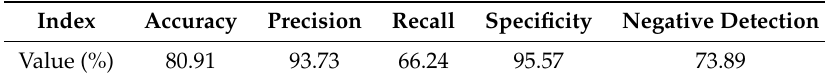
Table 21. Detection evaluation indices.